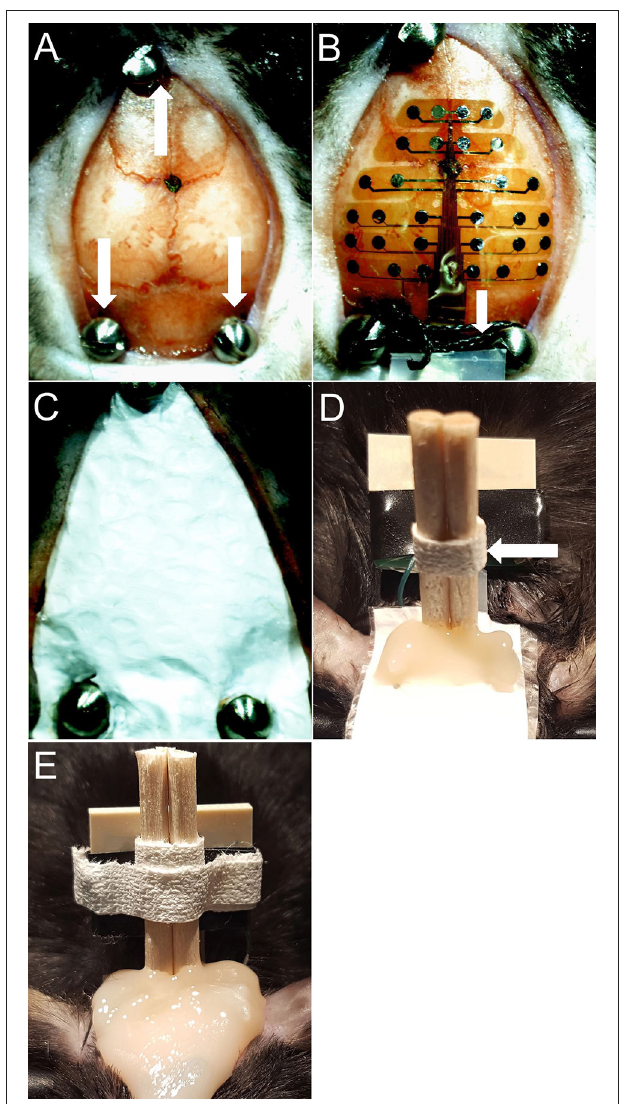
FIGURE 2 | (A) Bregma marked with screws in place. White arrows indicate screws. (B) Probe dried on skull with saline. White arrows indicate silk tie.